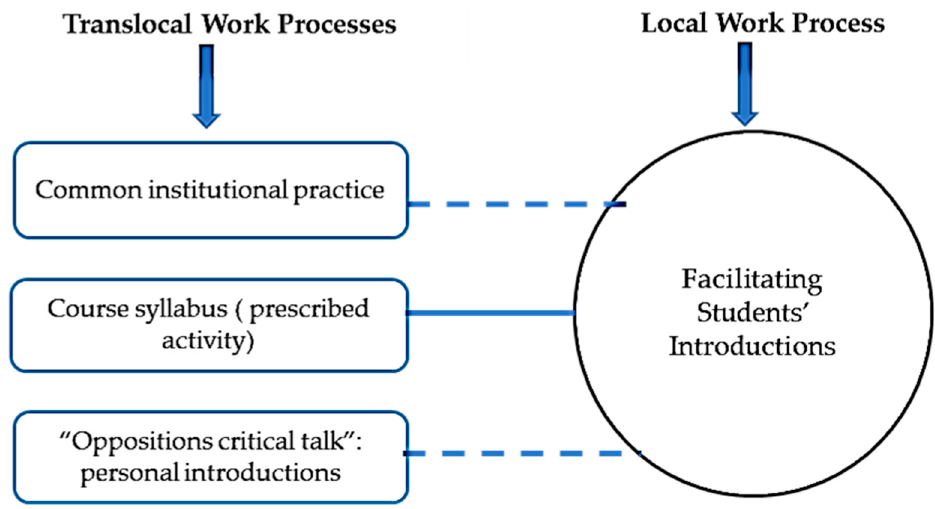
Figure 2. Students’ Introductions work